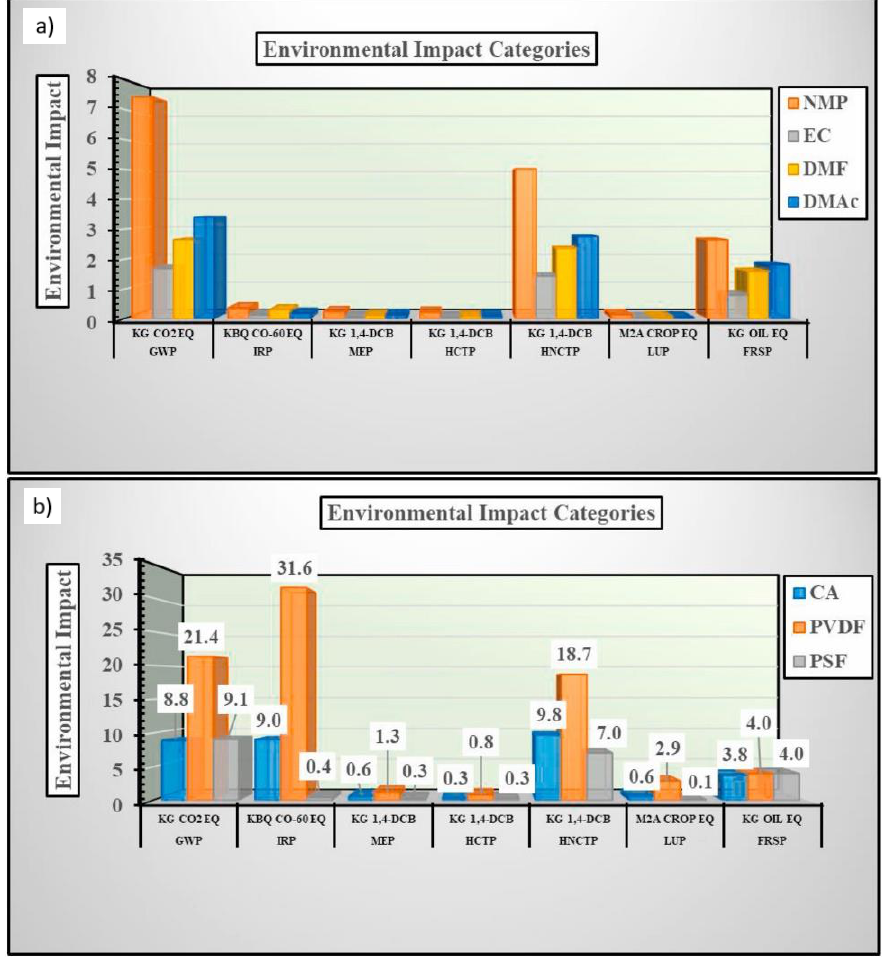
Figure 11. Magnitude of potential environmental impacts for producing 1 kg of conventional and green polymers; and ( a ) solvents ( b ). Reprinted from [117], Copyright 2021 Elsevier.